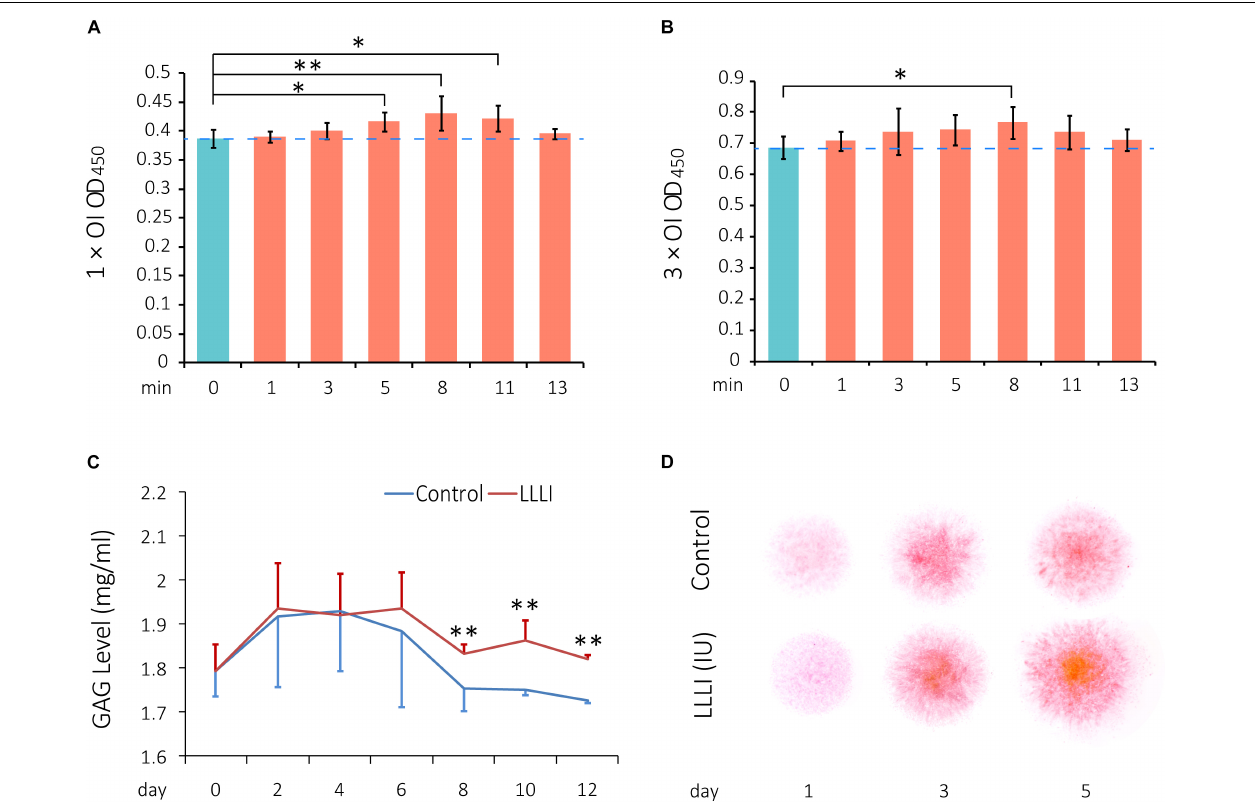
FIGURE 1 | Cell viability assay of LLLI-stimulated rabbit chondrocytes by MTS, measurement of released glycosaminoglycan (GAGs), and matrix deposition in micromass culture. (A) Chondrocytes were treated with the output intensity of LLLI for various time periods and cultured for 24 h before assay by MTS. (B) Chondrocytes were treated as (A) but with the output intensity daily in culture for 3 days and then analyzed by MTS. The figure was generated using data from triplicate samples, each of which were experimentally examined in triplicate. (C) GAGs released in the culture medium by the chondrocytes was measured using Alcian blue assays. The cells treated with LLLI of 5.74 J/cm 2 daily in culture showed no difference in GAG levels within the treatment period (0–6 days). Thereafter, GAG in LLLI-treated cells (red) maintained significantly higher levels than that in control cells (blue) in the post-treatment period (8–12 days) with a different trend. (D) Chondrocytes in micromass were treated with LLLI of 5.74 J/cm 2 daily in culture for 1, 3, and 5 days and changes in matrix deposition were detected by Safranin O staining, which showed an enhancement in a time- and LLLI dosage-dependent manner. Results are the mean ± SEM ( n = 4). OI = output power of 12 mW over 0.91 cm 2 . Error bar = SD. ∗ P < 0.05; ∗∗ P <